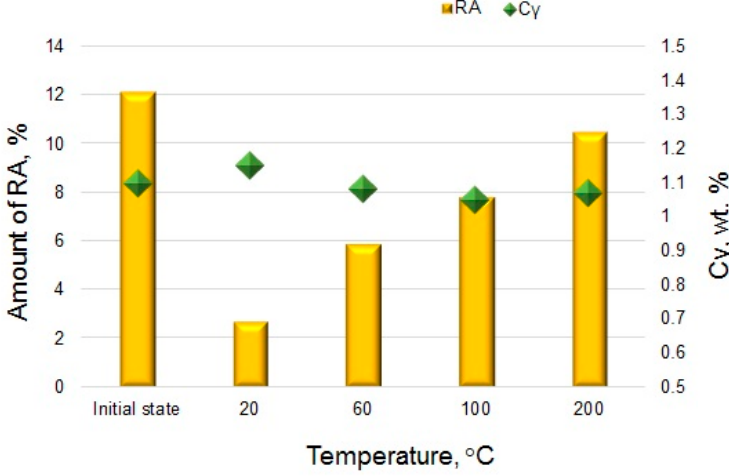
Figure 14. Fraction of retained austenite and its carbon content obtained by XRD analysis for steel in the initial state and deformed at 20, 60, 100, and 200